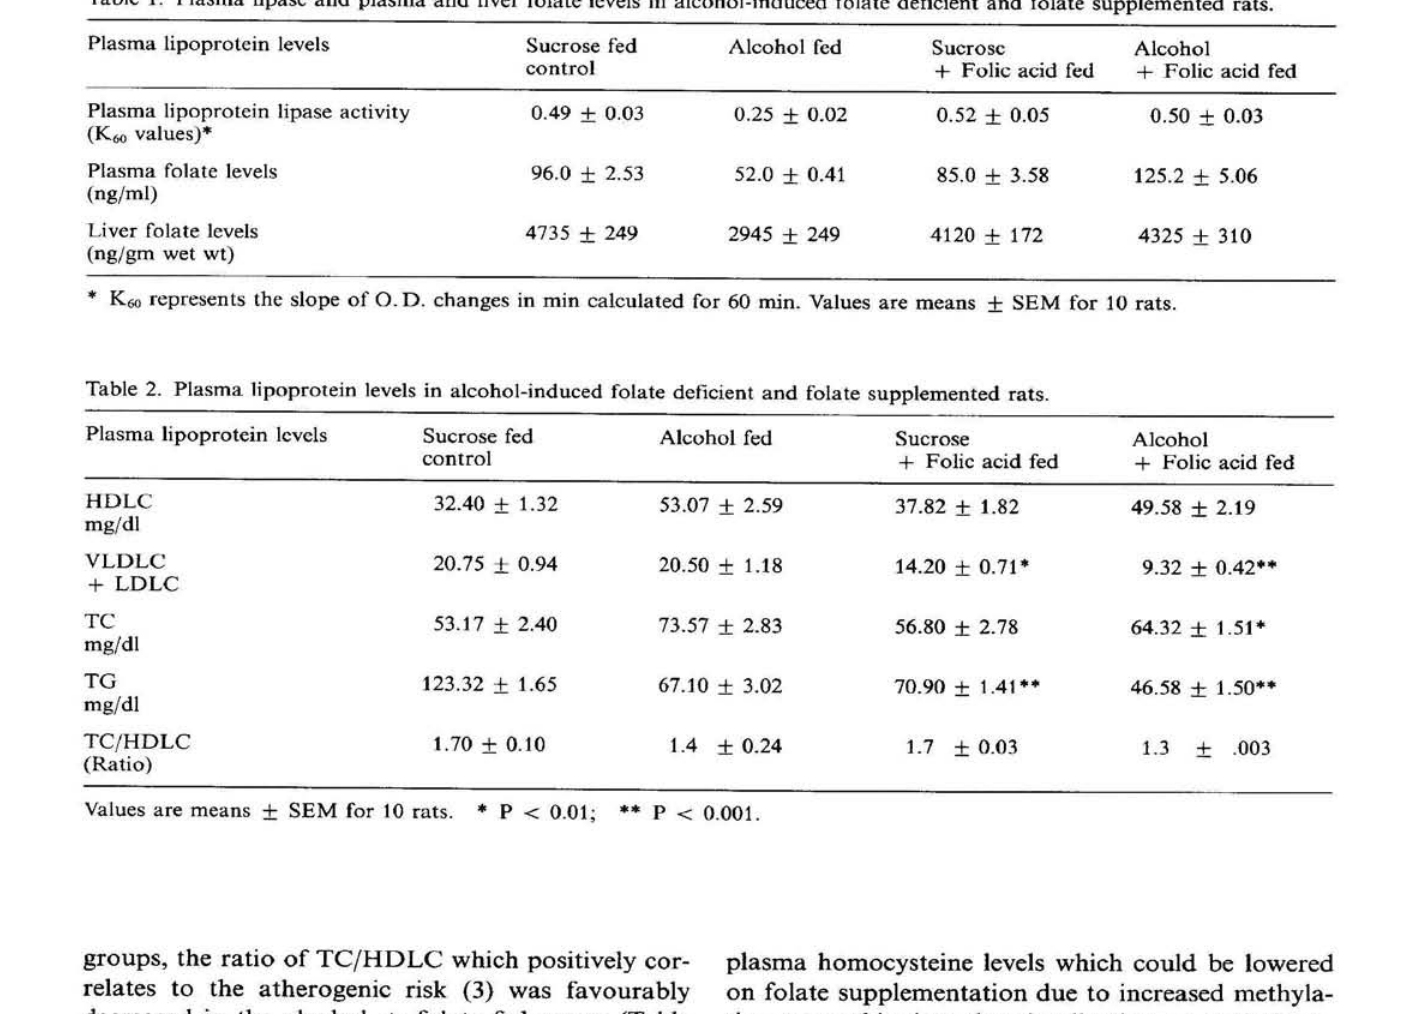
Table 1. Plasma lipase and plasma and liver folate levels in alcohol-induced folate deficient and folate supplemented rats. Plasma lipoprotein levels